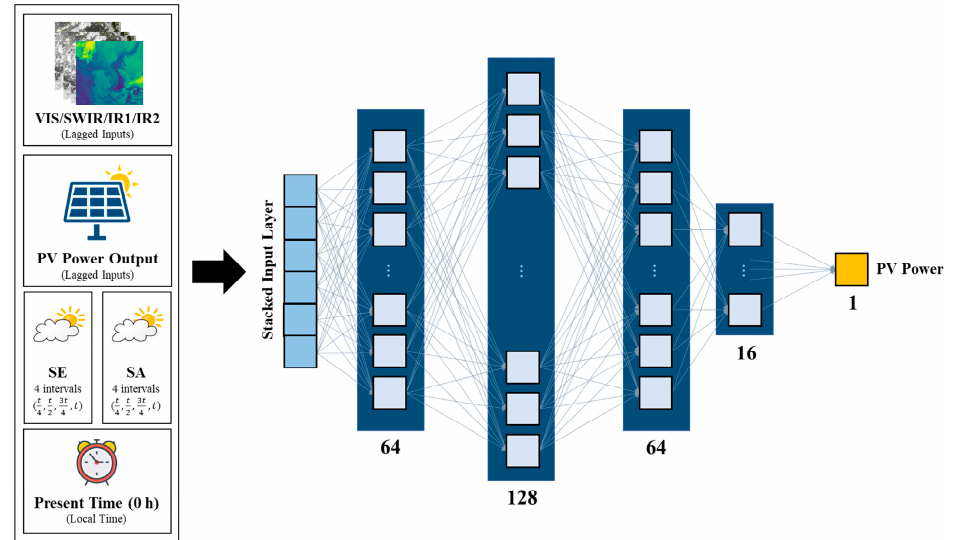
Figure 7. Structure of the deep neural network (DNN) model used in this study showing four hidden layers with 64, 128, 64, and 16 nodes in order of each layer, fully connected to forecast a single PV power output prediction for each hourly timestamp. The various input variables are also included in the diagram to depict the implementation of the input dataset into the input layer of the DNN.